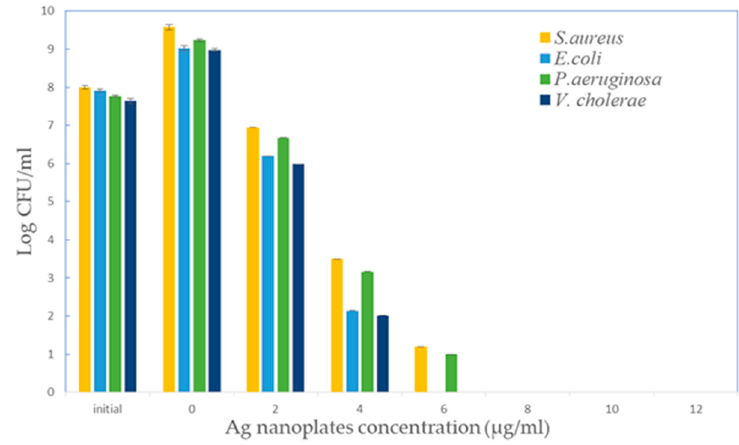
Figure 11. Growth inhibiton against S. aureus , E. coli , P. aeruginosa , and V. cholera supplemented with different concentrations of triangular silver nanoplates (from 2 to 12 μ